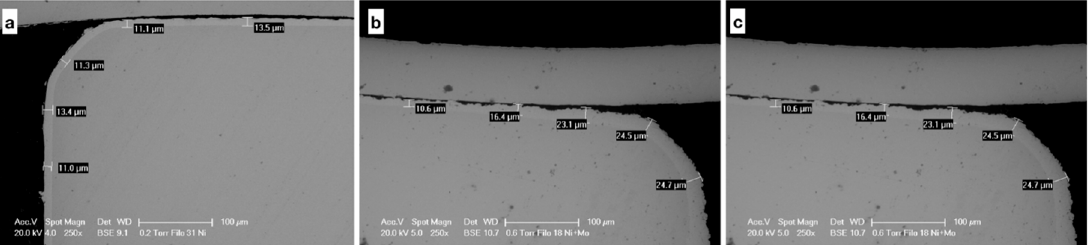
+ MoS + WS 2 , and ( c ) Ni 2